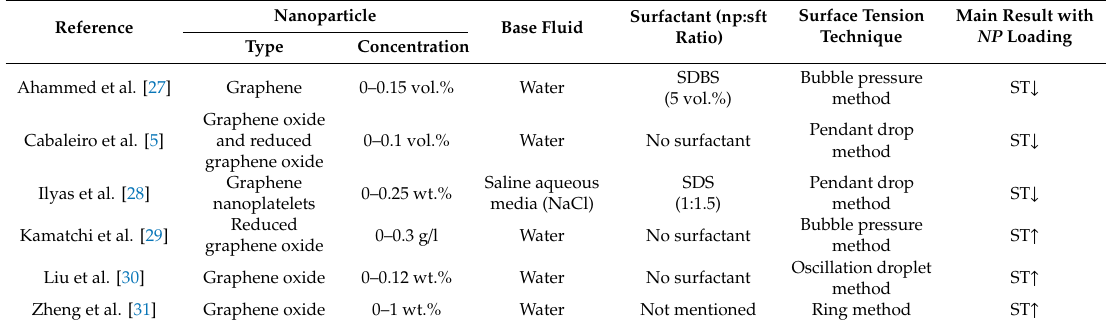
Table 1. Summary of previous surface tension studies on graphene